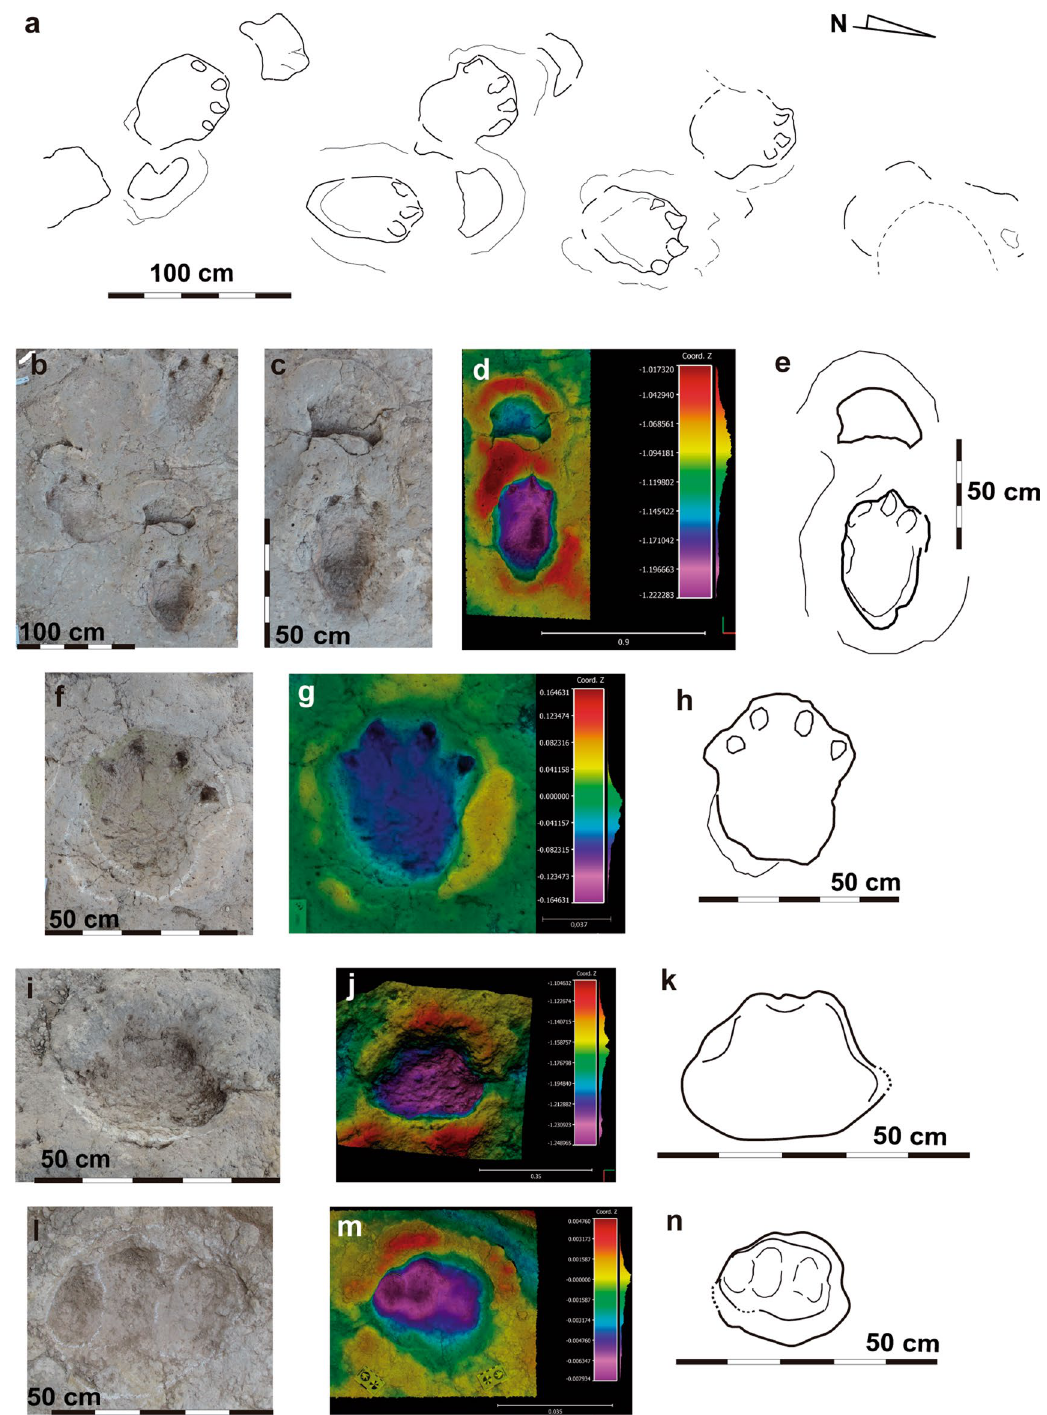
Figure 3. Las Sereas 7 tracksite. Holotype of Iniestapodus burgensis : ( a ) Interpretative cartography of LS7B trackway, modified from Torcida Fernández-Baldor et al. 15 . ( b ) Detail of the manus-pes sets LS7B,3p/m, 4p/m, and 5p. ( c-e ) Holotype LS7B,3p/m. ( c ) orthophoto; ( d ) false-color-depth map; ( e ) interpretative sketch. ( f-h ) Track LS7A,7p, right pes: ( f ) orthophoto; ( g ) false-color depth map; ( h ) interpretative sketch. ( i-k ) LS7A,8 m, left manus: ( i ) photography; ( j ) false-color depth map; ( k ) interpretative sketch. ( i-n ) LS7A,10m, right manus: ( l ) photography; ( m ) false*-color depth map; ( n ) interpretative sketch. The false-color depth map were generated with CloudCompare, a free software (http:// www. cloud compa re.